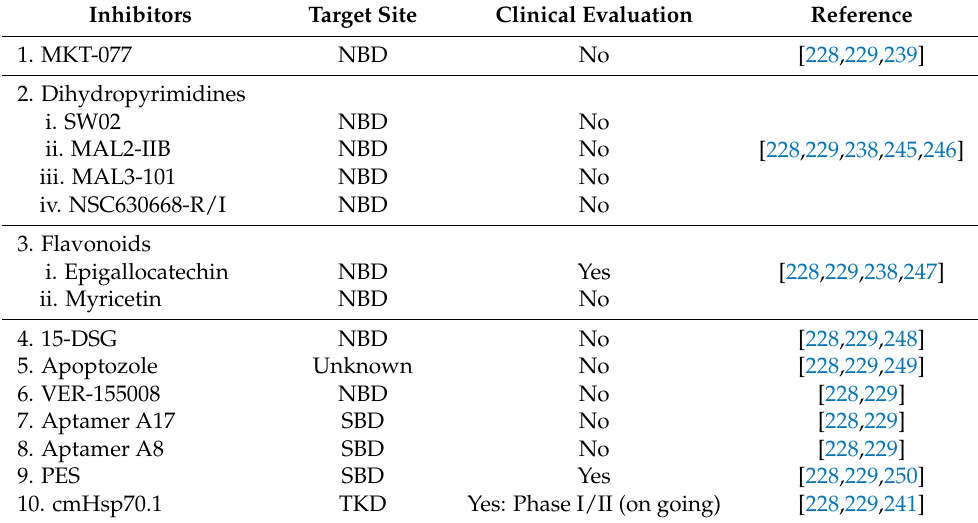
Table 2. Current status of HSP70 inhibitors with their sites of action and application in pre-clinical and clinical